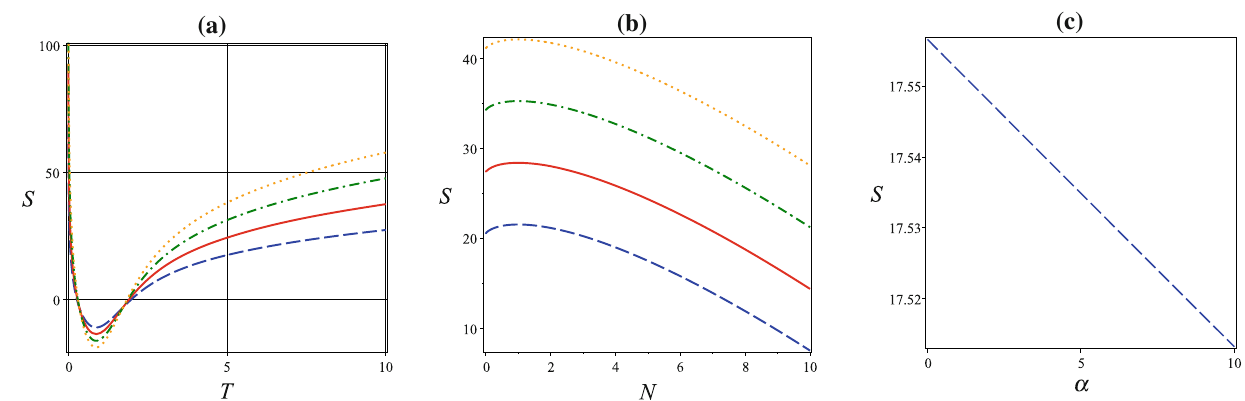
Fig. 3 Typical behavior of the entropy in terms of a T , b N and c α . N l = 3; l = 1 , 2 , 3 (blue dash), l = 1 , 2 , 3 , 4 (red solid), l = 1 , 2 , 3 , 4 , 5 (green dash dot); l = 1 , 2 , 3 , 4 , 5 , 6 (orange dot)